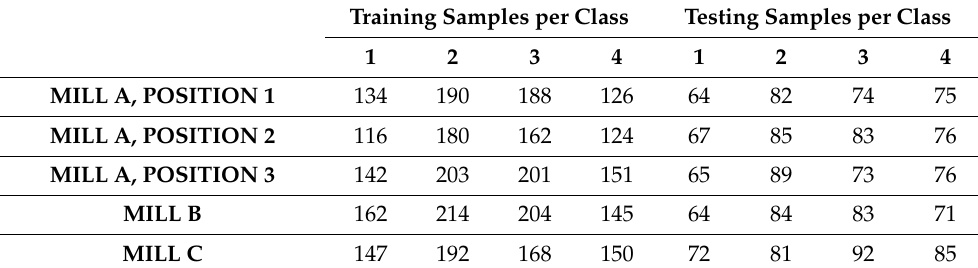
Table 5. Number of testing and training samples for different machines.